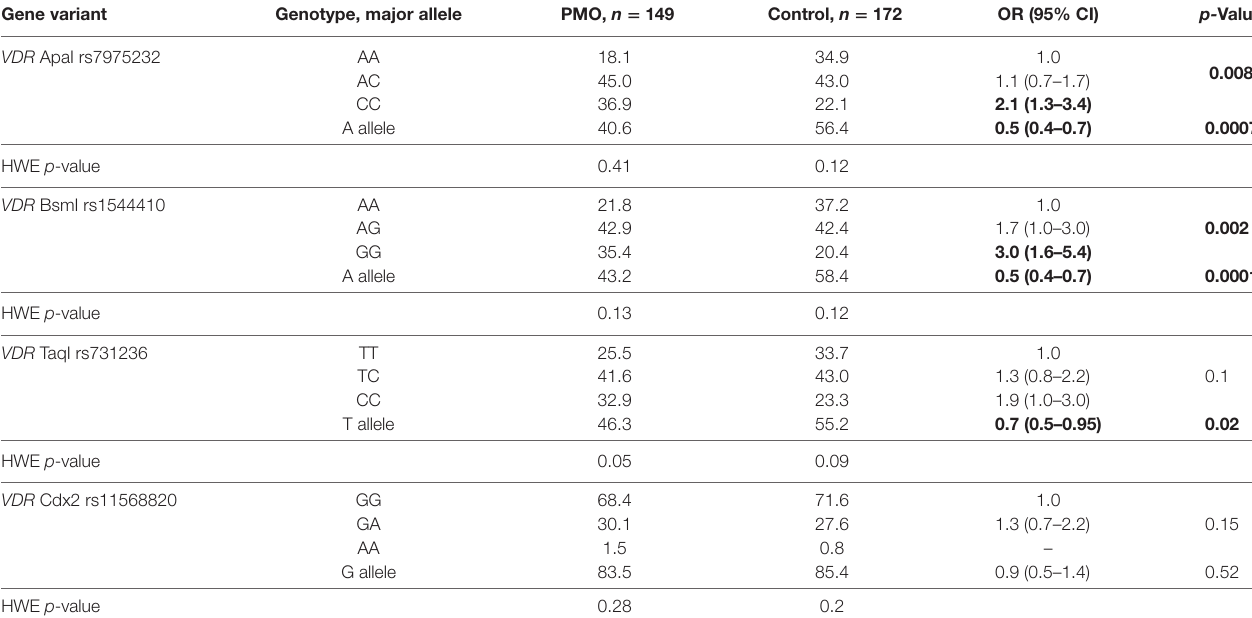
taBLe 2 | The genotype and allele frequencies (in %) of VDR gene